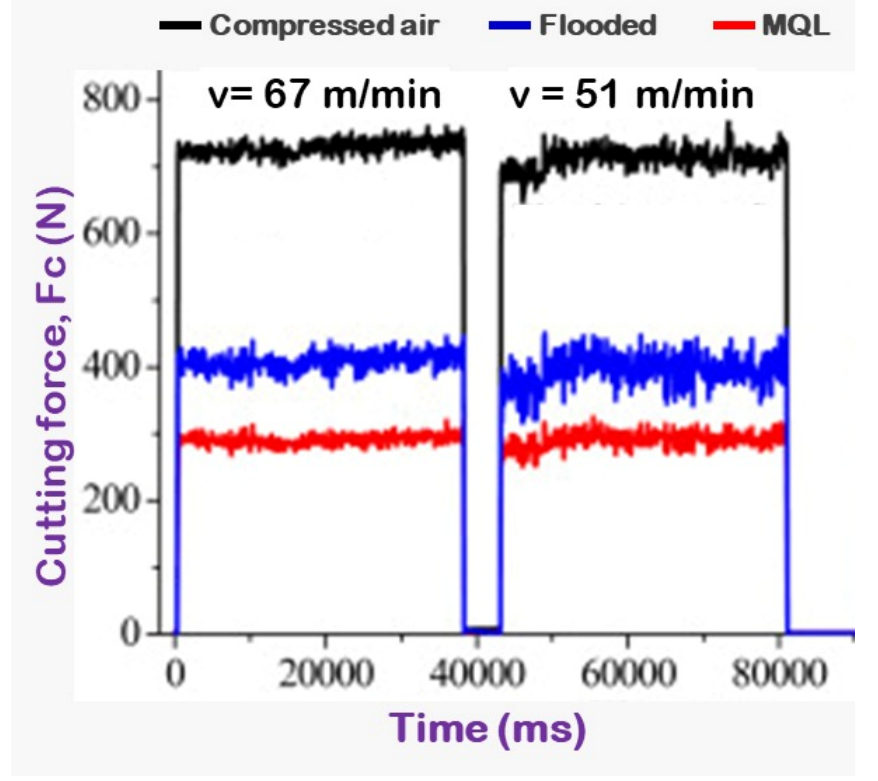
Figure 12. Principal cutting force under compressed-air, flood, and MQL environment at varying speeds. Adapted from [14].